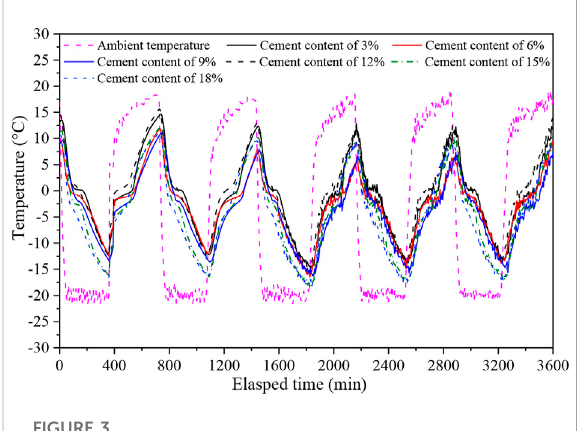
Variations in soil temperature during the freeze – thaw cycles.